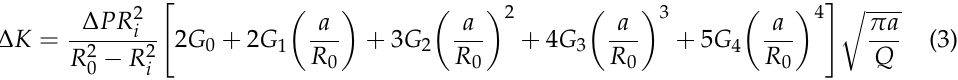
Figure 19. Fitting curve of fatigue-crack growth rate of weld ( a ) R = 0.1; ( b ) R = 0.6 .